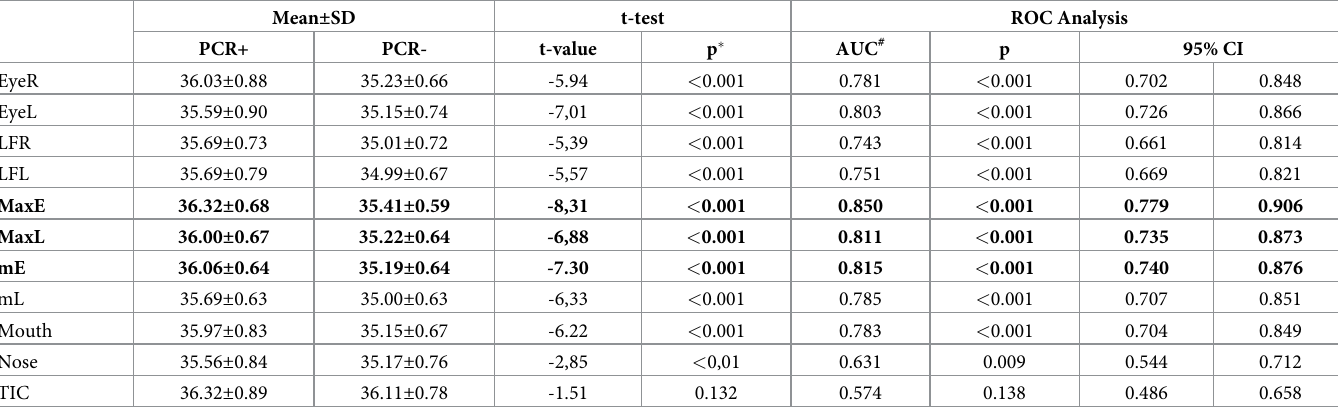
� p-values for means comparisons were obtained from t-student test for independent samples; # p-values for AUC comparisons were obtained from z-test at 95% confidence